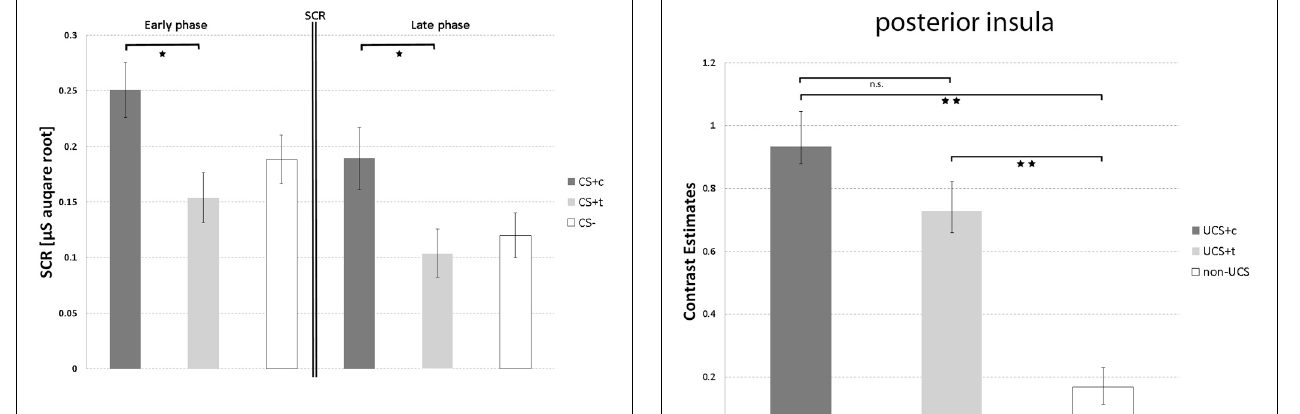
FIGURE 5 | SCR responses ( µ S, square root transformed, N = 12) over both acquisition phases. T-bars represent standard errors of the mean ( ± s.e.m.). ∗ p < 0 . 05.